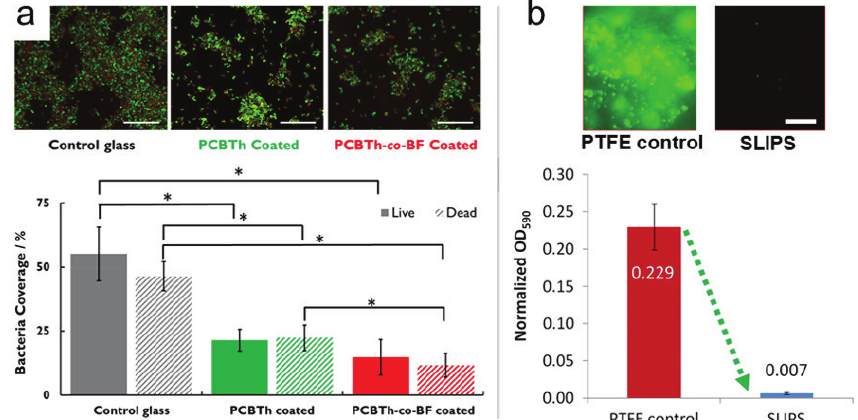
Figure 3. ( a ) Zwitterionic linear and porous polymers prevented bacteria growth on the surfaces. Scale bar = 20 µm. Adopted from [110]. ( b ) Superhydrophobic surfaces had excellent resistance to biofilm growth. Scale bar = 30 µm. Adopted from